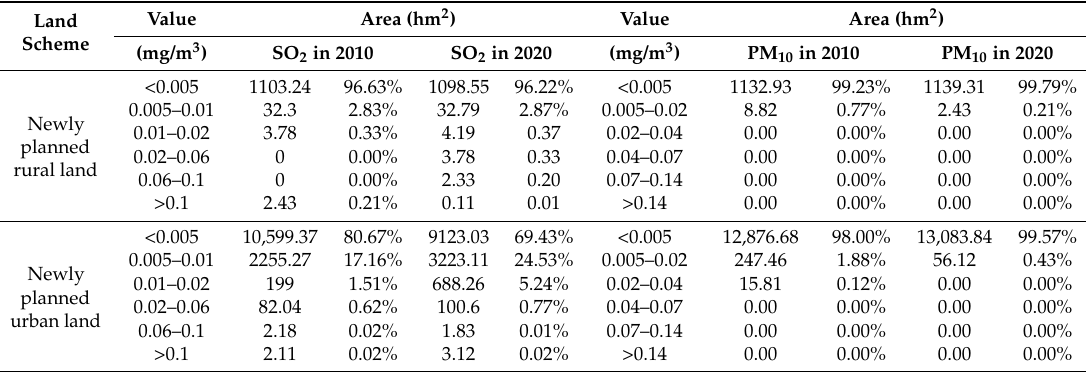
Table 4. Distribution of the SO2 and PM10 concentrations in the newly planned urban and rural land by 2020 in the LUP